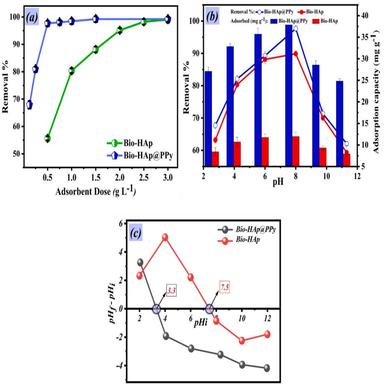
Effects of Dose (a) and pH (b), and (c) pH zero charge for Bio-HAp and Bio-HAp@PPy nanocomposite.